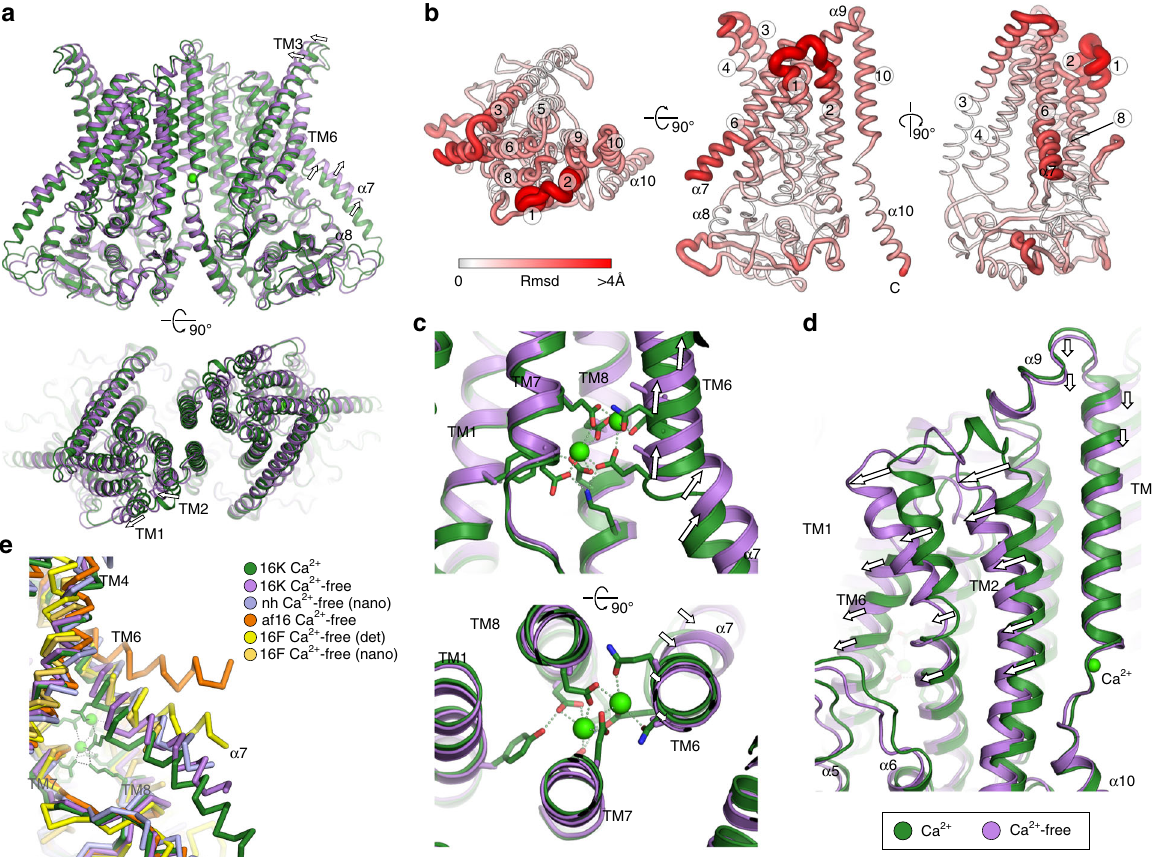
Fig. 7 Comparison of the Ca 2 + -free and 2 mM cryo-EM structures of TMEM16K. a Overall structure of Ca 2 + -free state (purple), superimposed on the Ca 2 + structure (green). b Global conformational differences between Ca 2 + and Ca 2 + -free structures. Schematic representations of the r.m.s. deviation (rmsd) in mainchain atomic positions mapped onto the monomer Ca 2 + -free structure. Monomers were superposed using all atoms with LSQKAB (CCP4). The monomer is viewed from the luminal face (left), perpendicular to the membrane normal (middle) and scramblase groove face (right). The thickness and colour of the tube re fl ects the magnitude of the r.m.s.d. between the two structures. The main differences are localised in TM1/2, TM6, α 7, TM9 and TM10. c View of the two Ca 2 + -binding site, showing overall movement of TM6. d View of the TM10- α 10 Ca 2 + -binding site, highlighting the lateral movement of TM1-2, TM6 away from the dimer interface. e Comparison of the Ca 2 + -free structure with those from nh TMEM16 (PDB: 6qm4), afTMEM16 (PDB: 6dz7), and mTMEM16F in detergent (PDB: 6qpb) and nanodiscs (PDB: 6qpi). The 2 mM TMEM16K Ca 2 + structure with an intact dual calcium binding site (green) is shown for